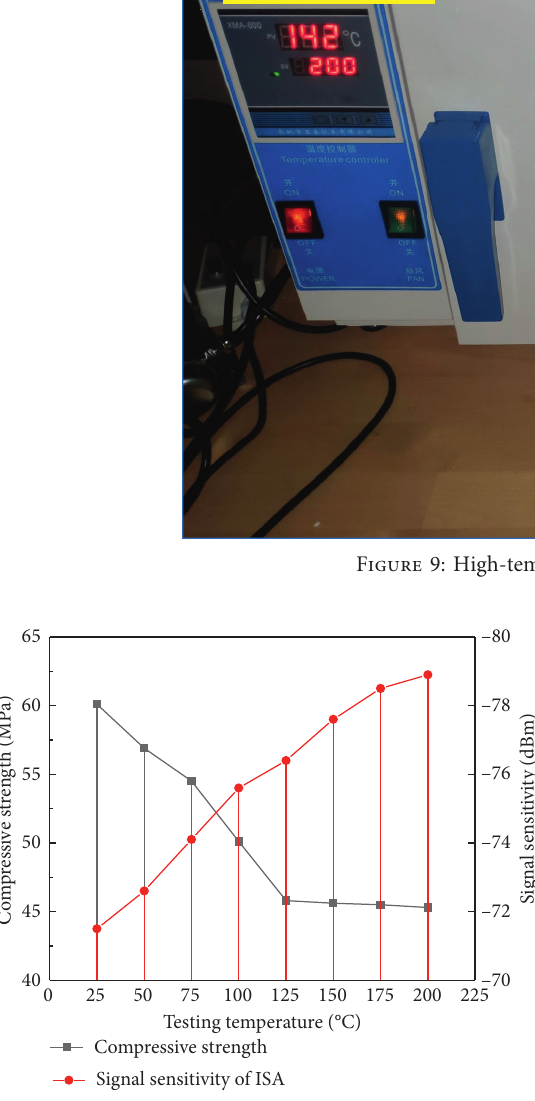
Figure 10: Test results of high-temperature resistance of